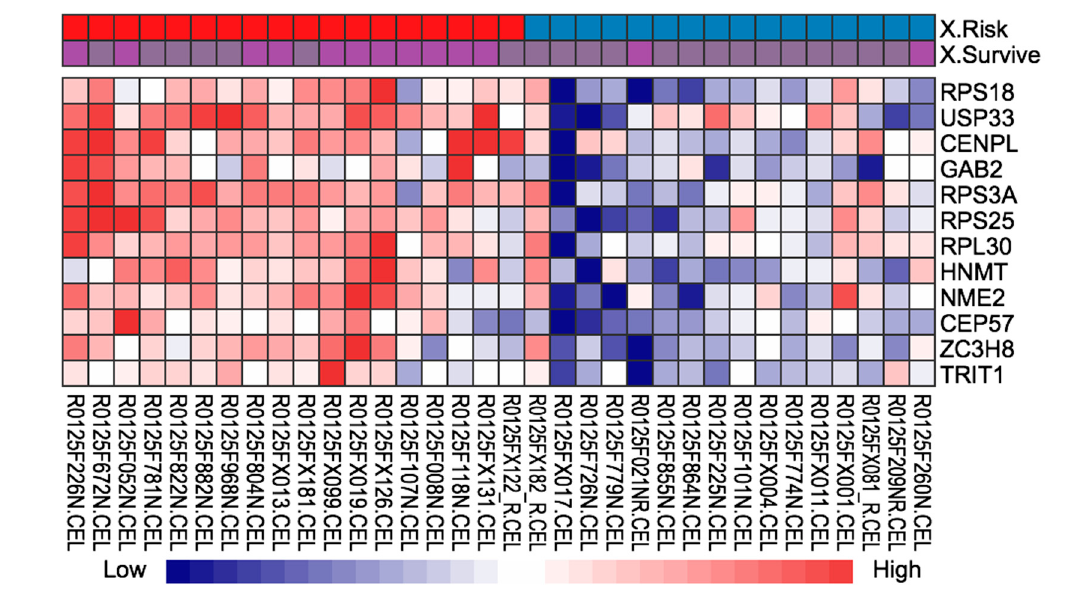
Figure 3. Differentially expressed genes identified from the arrayexpress datasets. Lower horizontal axis marks sample names, and right vertical axis represents gene names. Red represents up-regulated genes and blue represents down-regulated genes.